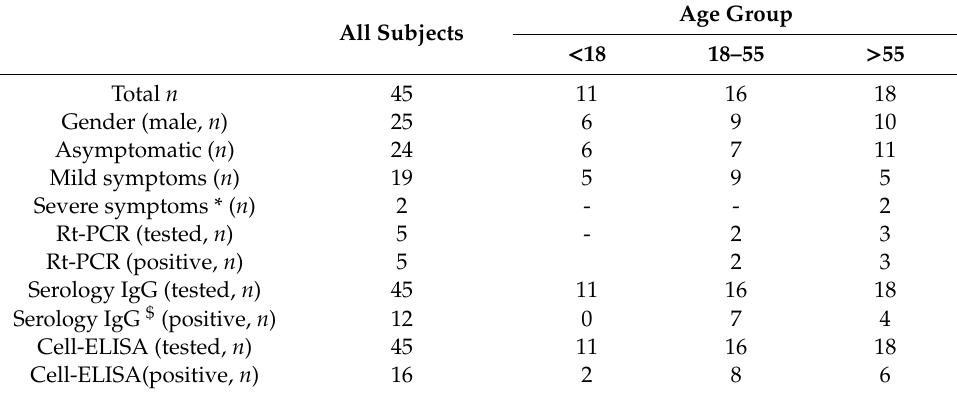
Table 1. Demographic and clinical characteristics of the recruited patients in the whole sample and by age group. The asymptomatics declared no symptoms attributable to COVID-19 before serology testing by ELISA. They were tested to obtain their anti-SARS-CoV-2 serological response as contacts of confirmed cases. The symptomatics declared either mild symptoms (one or more of the listed symptoms below) not requiring medical assistance, or severe symptoms and received medical assistance at home, or hospitalized. The main symptoms associated with COVID-19 were: fever or chills, cough, shortness of breath or di ffi culty breathing, fatigue, muscle or body aches, headache, new loss of taste or smell, sore throat, congestion or runny nose, nausea or vomiting,